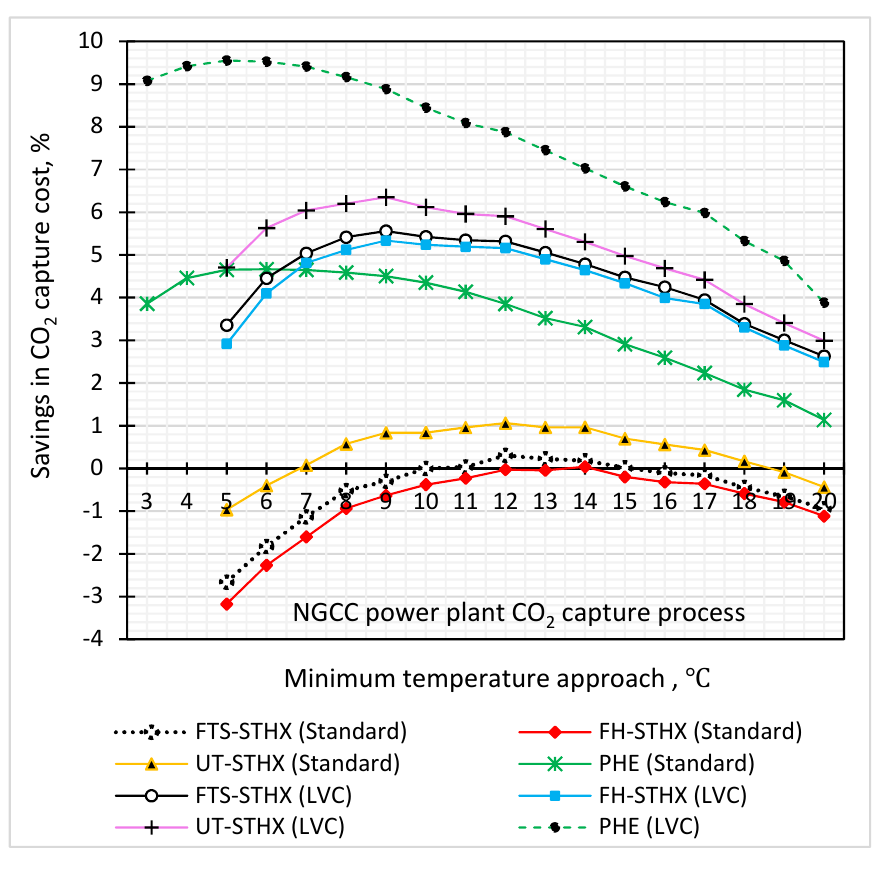
Figure 11. Cost reduction analysis at different ∆ T min for different heat exchanger types compared with FTS–STHX of ∆ T min = 10 ◦ C in the NGCC power plant capture